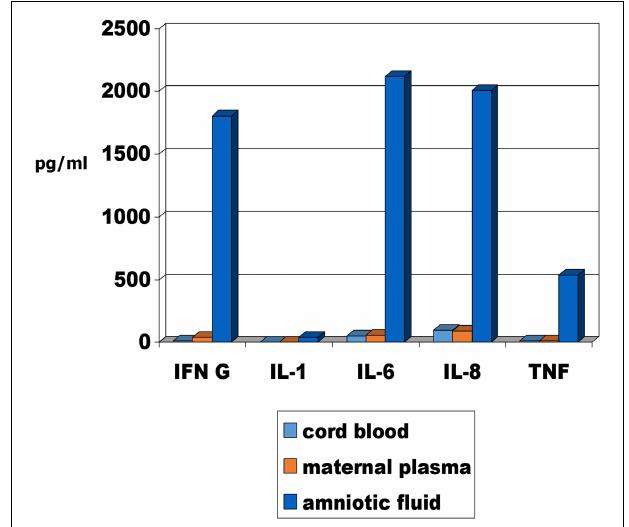
FIGURE 1 | Median pro-inflammatory cytokine levels in maternal plasma, cord blood and amniotic fluid of 24 mothers and infants obtained from elective Caeserean delivery [adapted from Burns et al. (49)] .